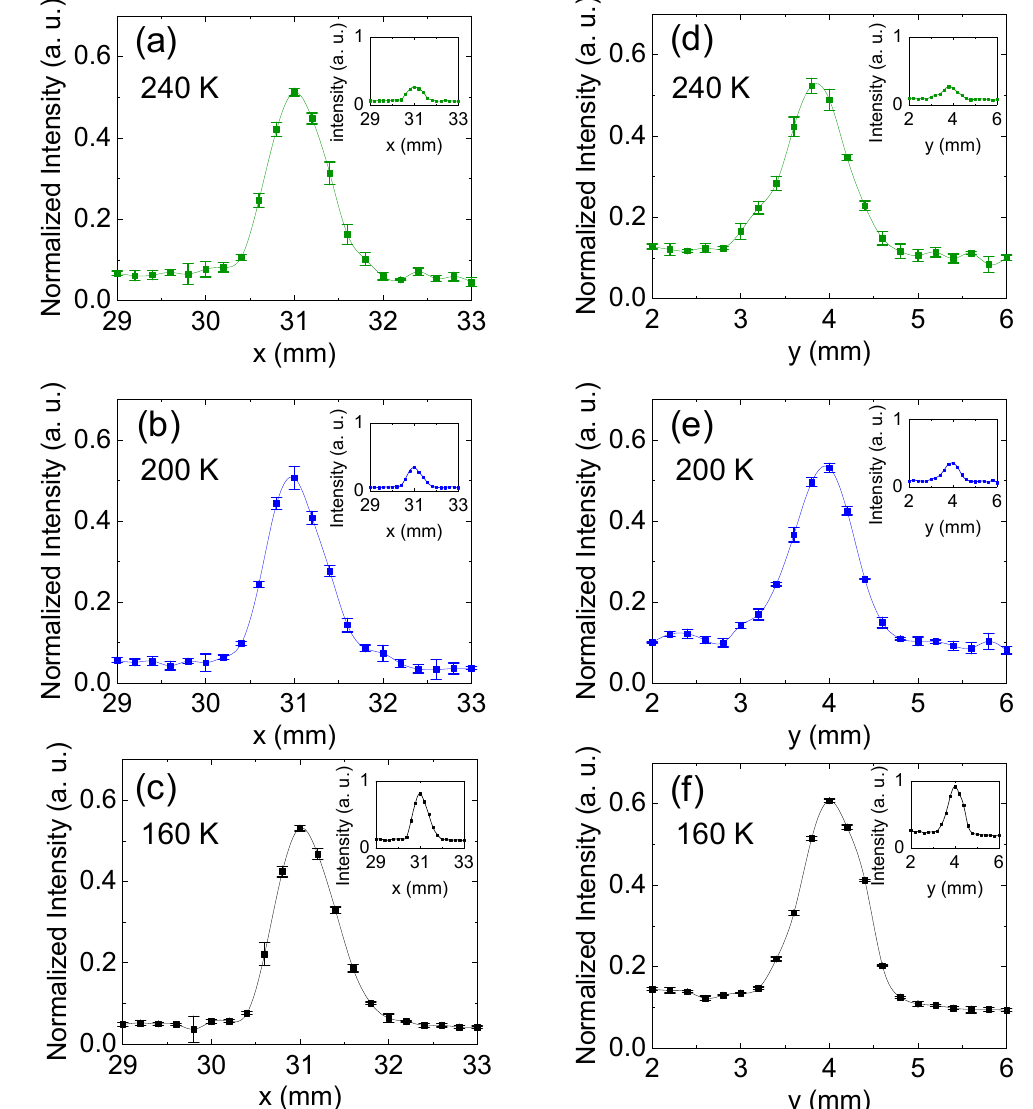
Figure 7. Line profiles of normalized THz intensity along horizontal direction at: ( a ) 240 K, ( b ) 200 K and ( c ) 160 K. Line profiles of normalized THz intensity along vertical direction at: ( d ) 240 K, ( e ) 200 K and ( f ) 160 K. Insets show profiles of non-normalized intensity.